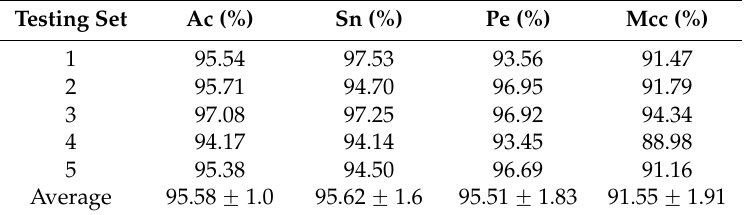
Table 2. Five-fold cross validation results shown using our proposed method on H. pylori